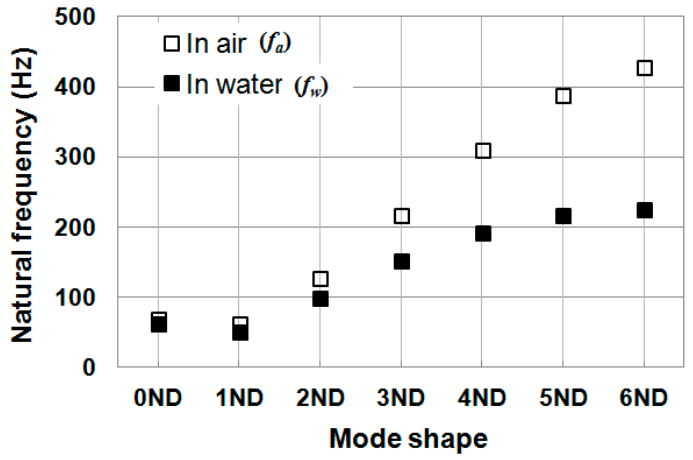
Figure 13. Natural frequencies of the runner in air and in water.